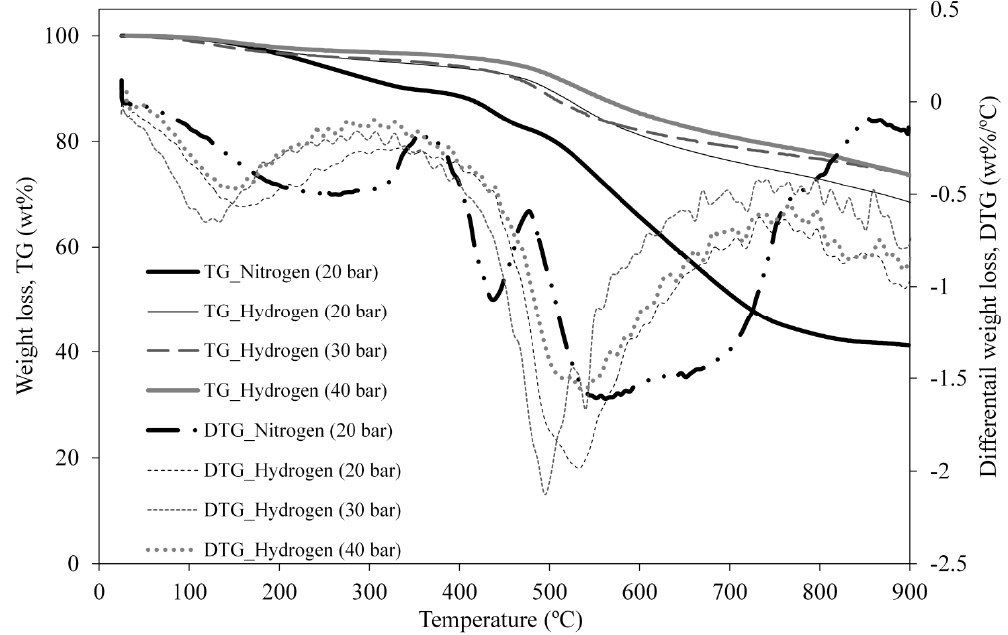
Figure 4. Thermogram of the recovered catalyst after experiment under N 2 and H 2 (20–40 bar). Standard deviations ±2.6 wt % (N 2 ), ±1.8 wt % (H 2 , 20 bar), ±1.1 wt % (H 2 , 30 bar) and 1.3 wt % (H 2 , 40 bar).